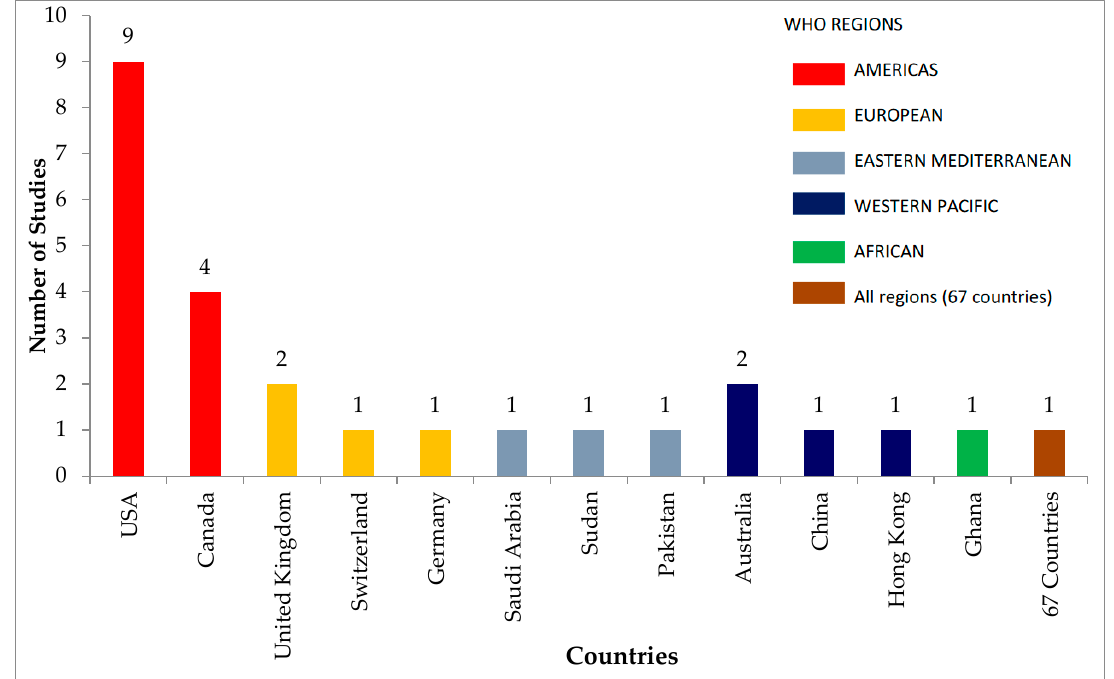
Figure 2. Number of included studies per WHO region and country.